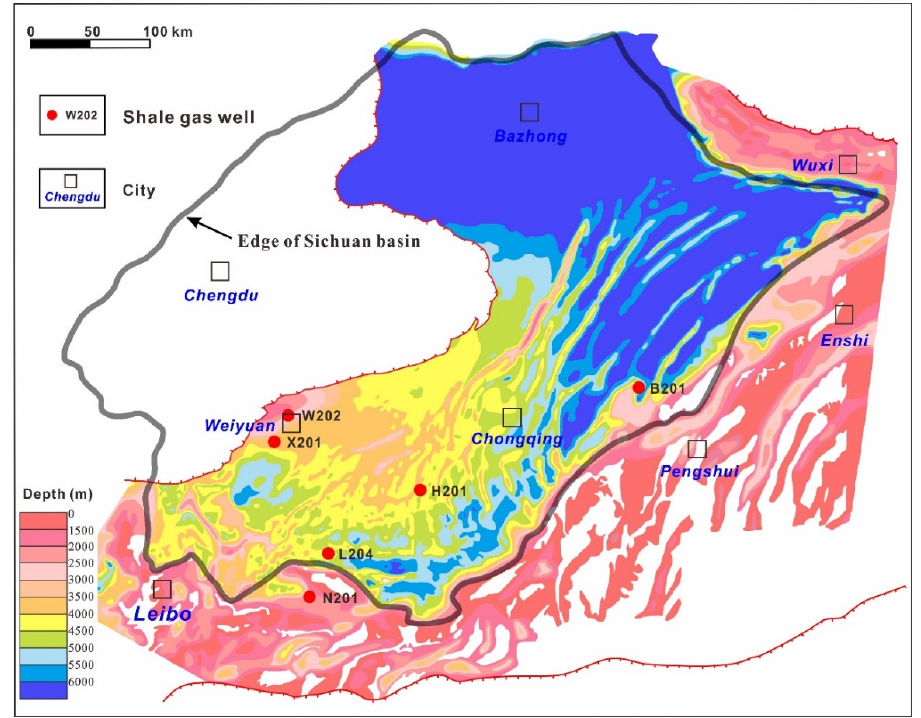
Figure 2. The true vertical depth (TVD) of the Wufeng–Longmaxi formations in the Sichuan basin and the location of the wells [3].